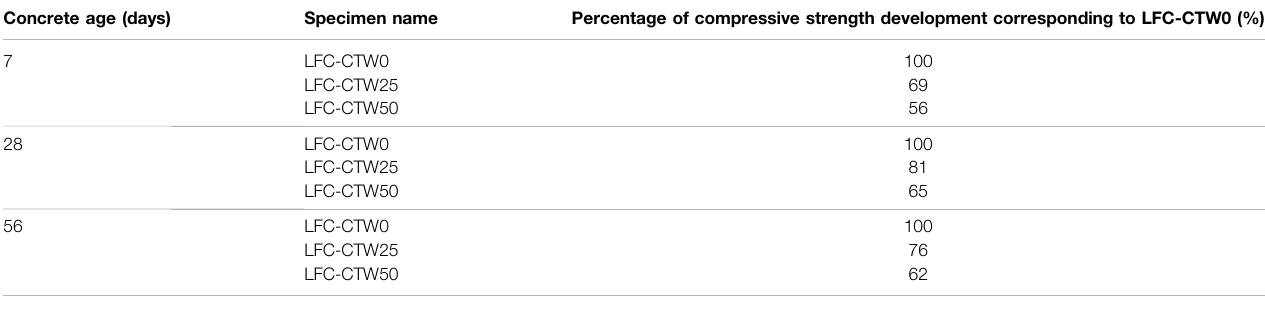
TABLE 4 | Effect of incorporation of ceramic tile wastes in lightweight foamed concrete on its compressive strength at various concrete ages.